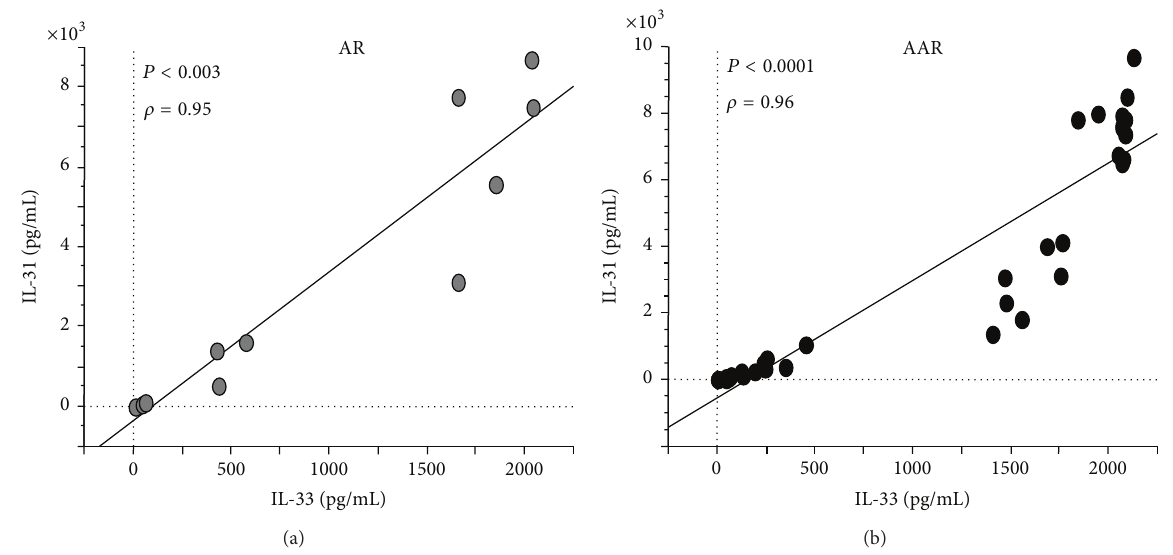
Figure 2: Correlation between plasma IL-31 and IL-33 concentrations in (a) AR patients ( 𝑛 = 11 ) and (b) AAR patients ( 𝑛 = 35 ). Statistical analysis was performed by Spearman rank test. Significance was accepted at 𝑃 < 0.05 .